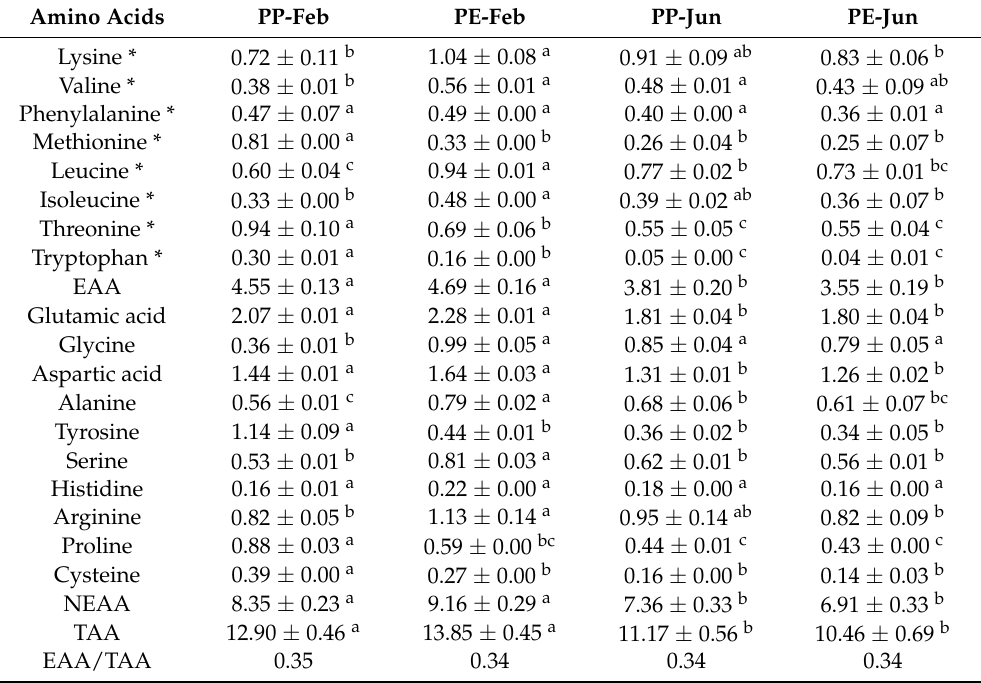
Table 4. The contents of amino acids of two P. f. martensii selective strains in different seasons (g/100 g wet